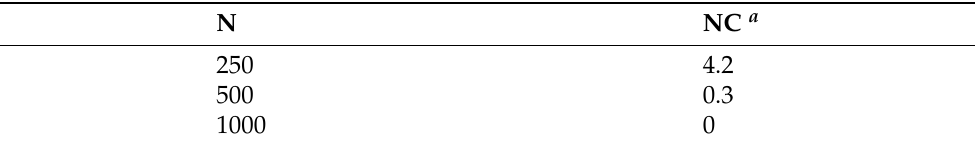
Table A2. Non-Convergence of the Iterated IPC Regression